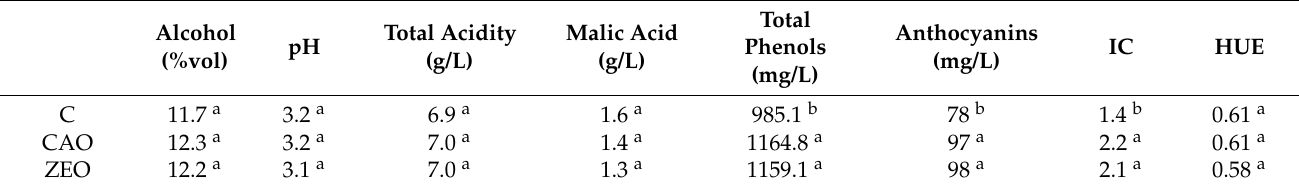
Table 7. Chemical analysis on wines obtained from kaolin (CAO) and chabazite rich-zeolitite (ZEO) treatments or the control (C) grapes in 2020. The wines were analyzed three months after harvest. Different letters in a column for a given year indicate significant differences after the Tukey statistical analysis test ( p ≤